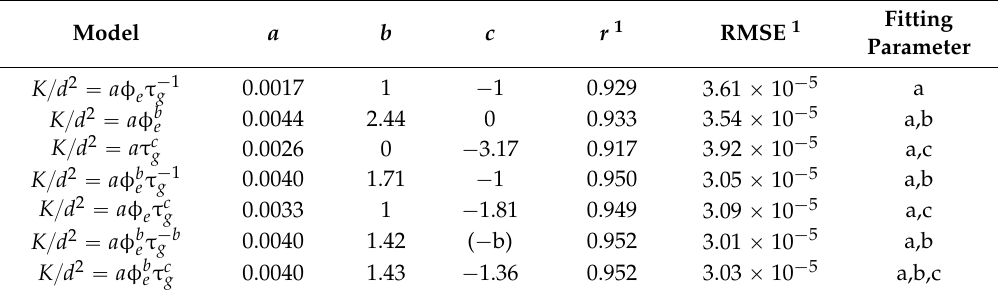
1 r = correlation coefficient, RMSE = root mean square (residual) error.